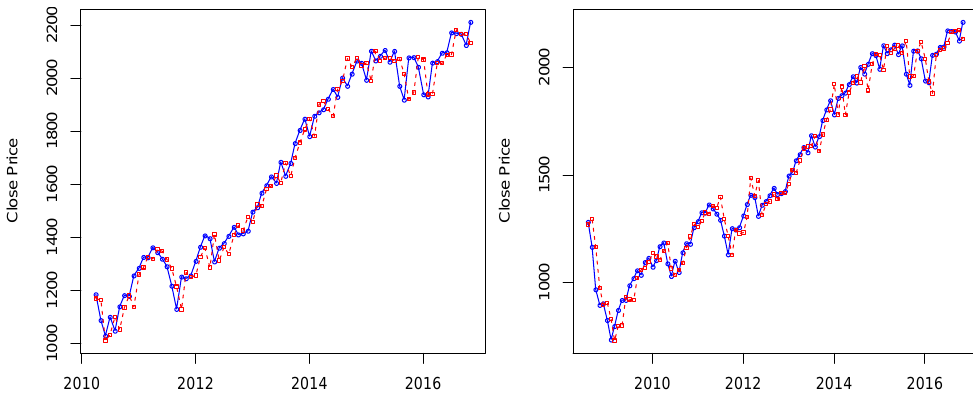
Figure A2. S&P 500 ’s predicted prices using the four-state HMM for 80-month out-of-sample period ( left ) and 100-month out-of-sample period ( right